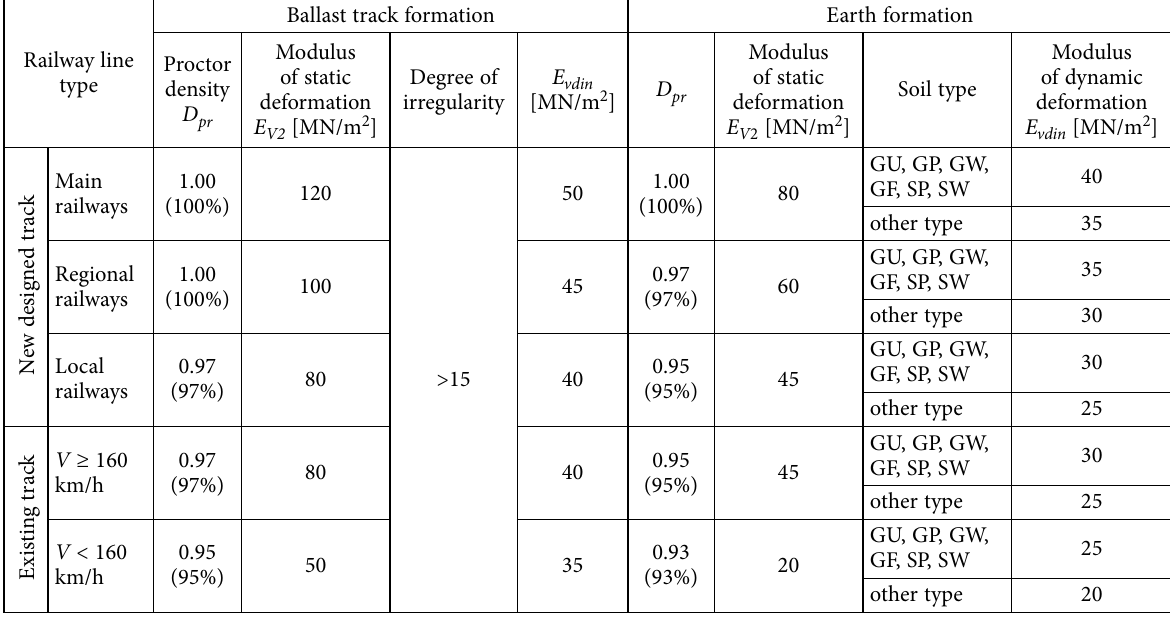
Fig. 4. Schematic railway cross section for track in Table 3. Minimum values of the modulus of deformation, Proctor density and modulus of dynamic deformation for railway lines in Serbia (Železnice Srbije 2006)